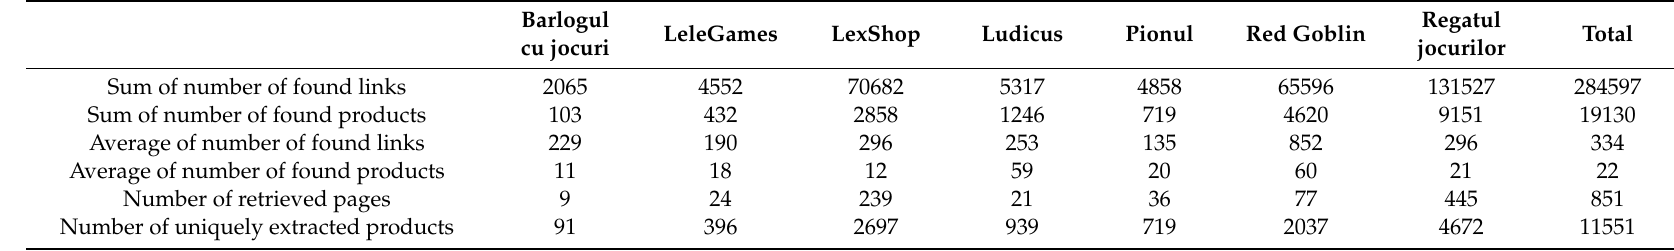
Table A2. Number of links and products found per page, the number of retrieved pages, and the total number of uniquely extracted products in the last